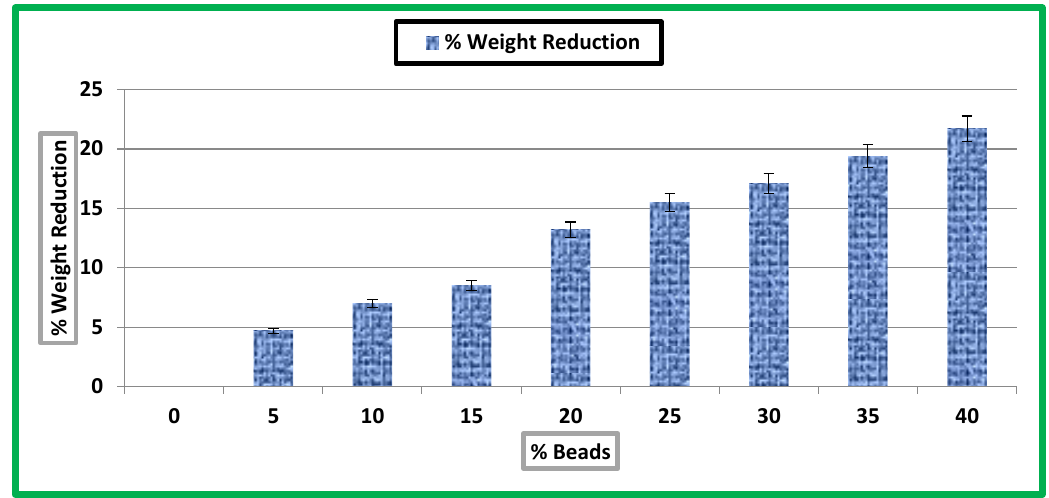
Figure 8. Weight (Dead Load) reduction w.r.t percentage beads in addition.